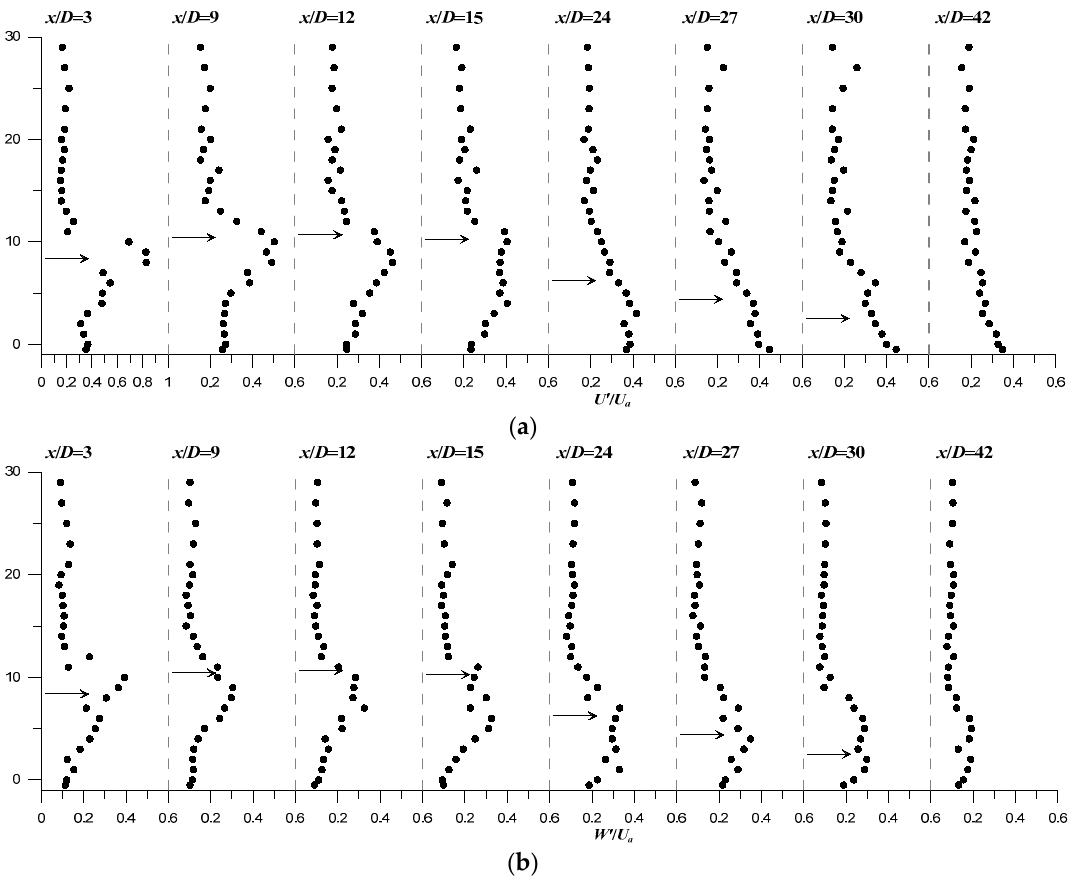
Figure 8. Vertical profiles of the flow turbulence intensity at different downstream positions x / D along the plane of flow symmetry ( y = 0) of run R1: ( a ) U’ / U a ; ( b ) W’ / U a . The horizontal arrow on the profiles indicate the position of the jet axis.